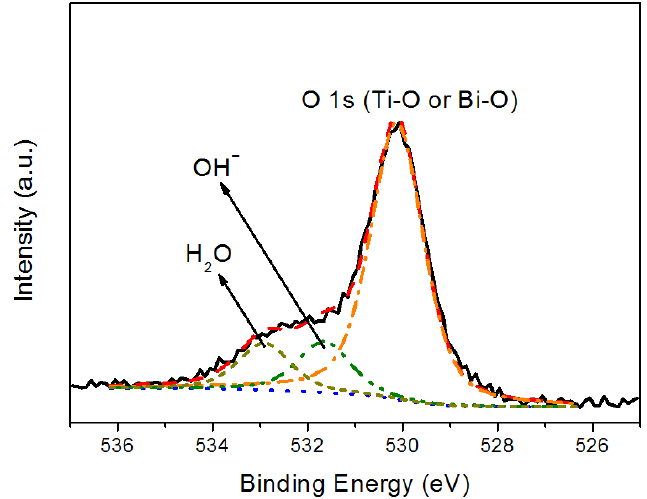
Figure 5. O 1s XPS spectrum recorded from the